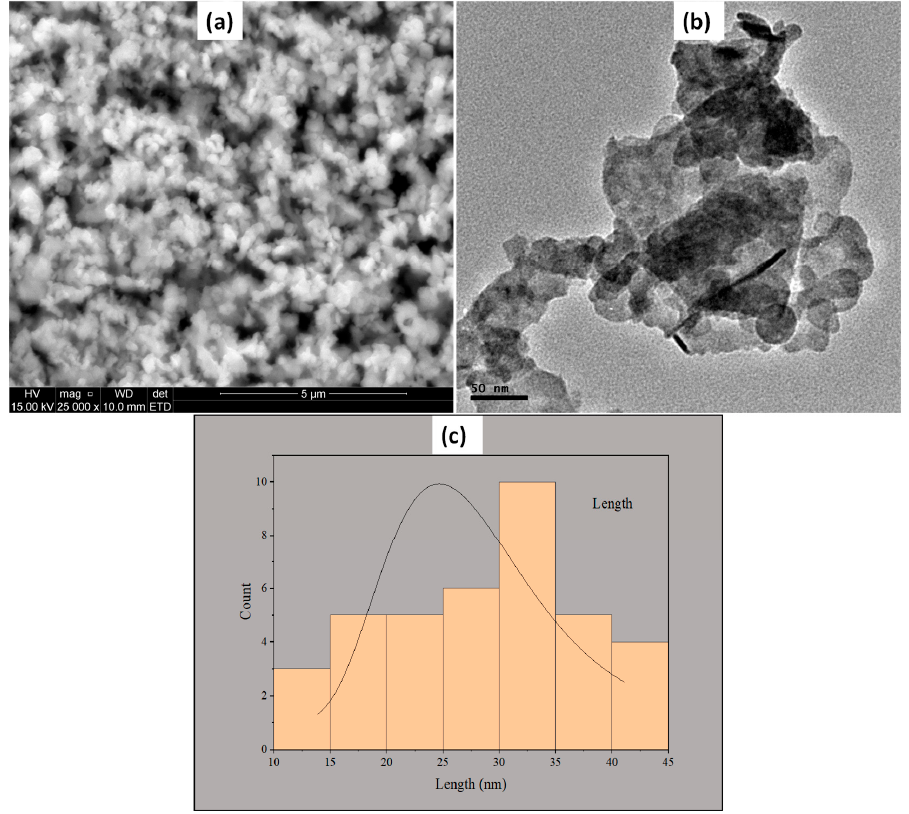
Figure 4. ( a ) SEM, ( b ) TEM images, and ( c ) particle size distribution histogram inset of ZnO-NPs synthesized without C. chinense fruit extract.